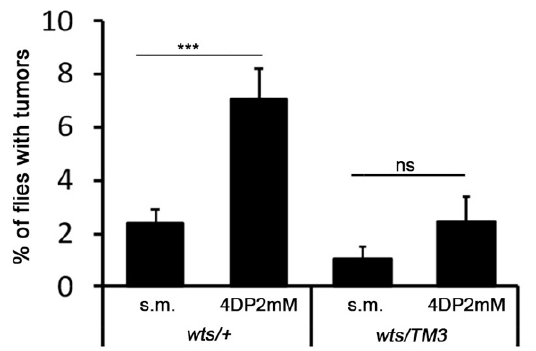
prevents LOH. Each column represents the mean value ± SEM. For each condition, more than Figure 3. Mitotic recombination as a possible mechanism of LOH. The TM3 balancer chromosome ns = non-significant Chi-square test. s.m. = standard medium; 4DP = 4 prevents LOH . Each column represents the mean value ± SEM. For each condition, more than 500 flies were examined in three different experiments. *** significant Chi-square test with p < 0.001; ns = non-significant Chi-square test. s.m. = standard medium; 4DP = 4 deoxypyridoxine.